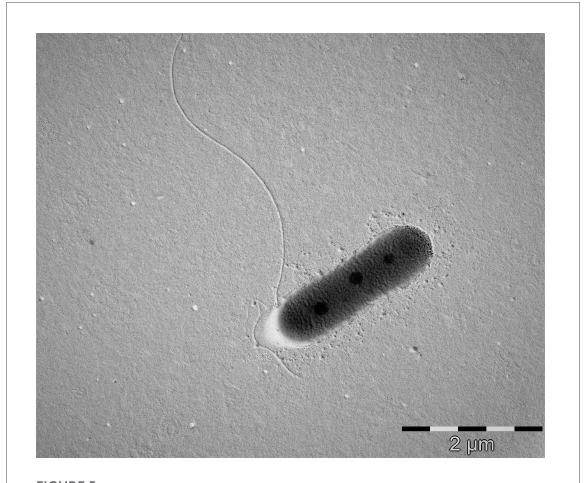
FIGURE5 Transmission electron microscopic photograph showing cell morphology and presence of flagella in strain MAP12 T . Bar = 2 µ m.